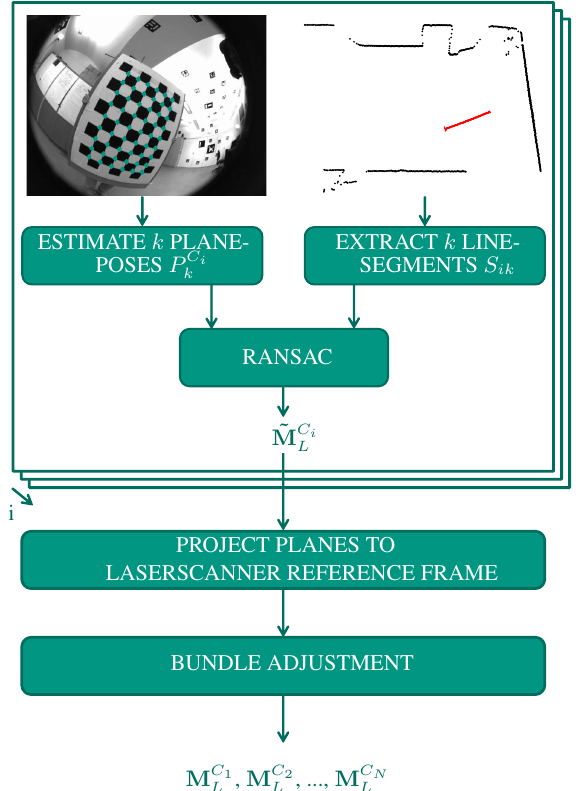
Figure 2: Calibration methodology. The top part depicts the estimation of a single camera to a laserscanner (Section 3.2). This part is performed for each camera C i . The remaining projection and bundle adjustment are performed just once to calibrate the entire system (Section 3.3). For simplification the figure does not show the intrinsic camera calibration, which can also be estimated based on the calibration plane observed in different